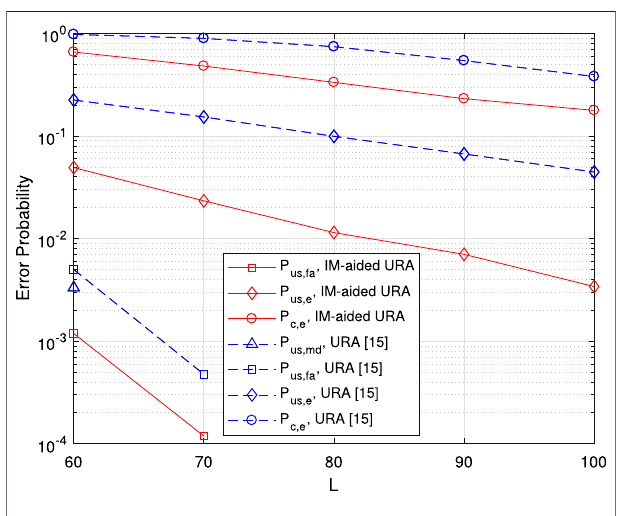
FIGURE 9 | Error probability vs. channel blocks length L. Here, the numbers of BS antennas and active users are M (cid:1) 100 and K a (cid:1) 200, respectively. For user-speci fi c information, misdetection is observed only at L (cid:1) 60 in conventional URA (Fengler et al., 2019) and false alarm is observed only at L (cid:1) 60 and L (cid:1) 70 in both schemes.